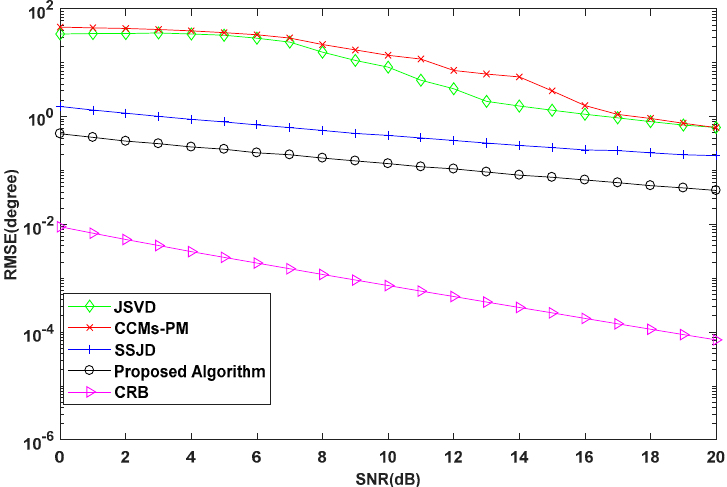
Figure 6. RMSE performance versus signal-to-noise-ratio (SNR) for simulations with 100 snapshots.